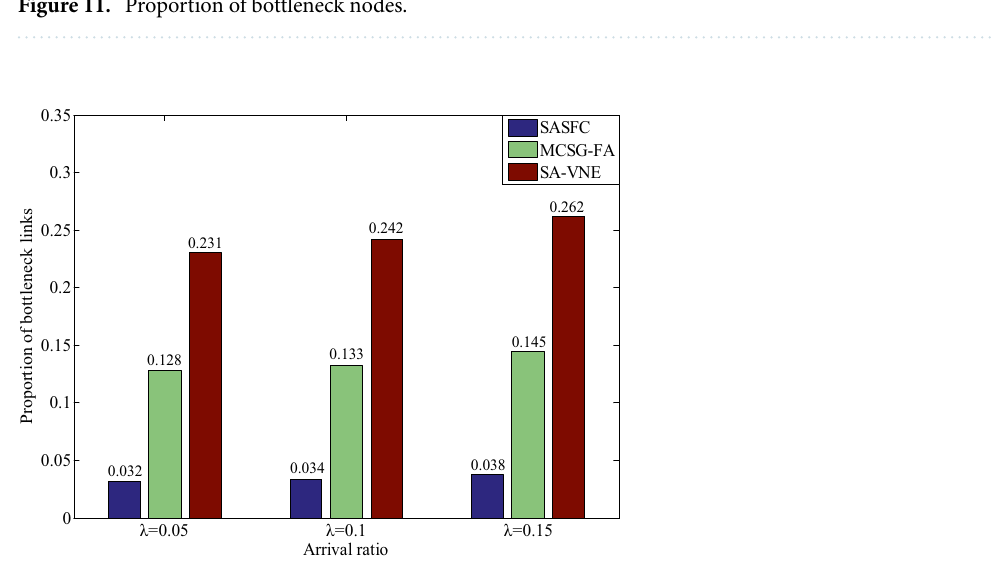
Figure 12. Proportion of bottleneck